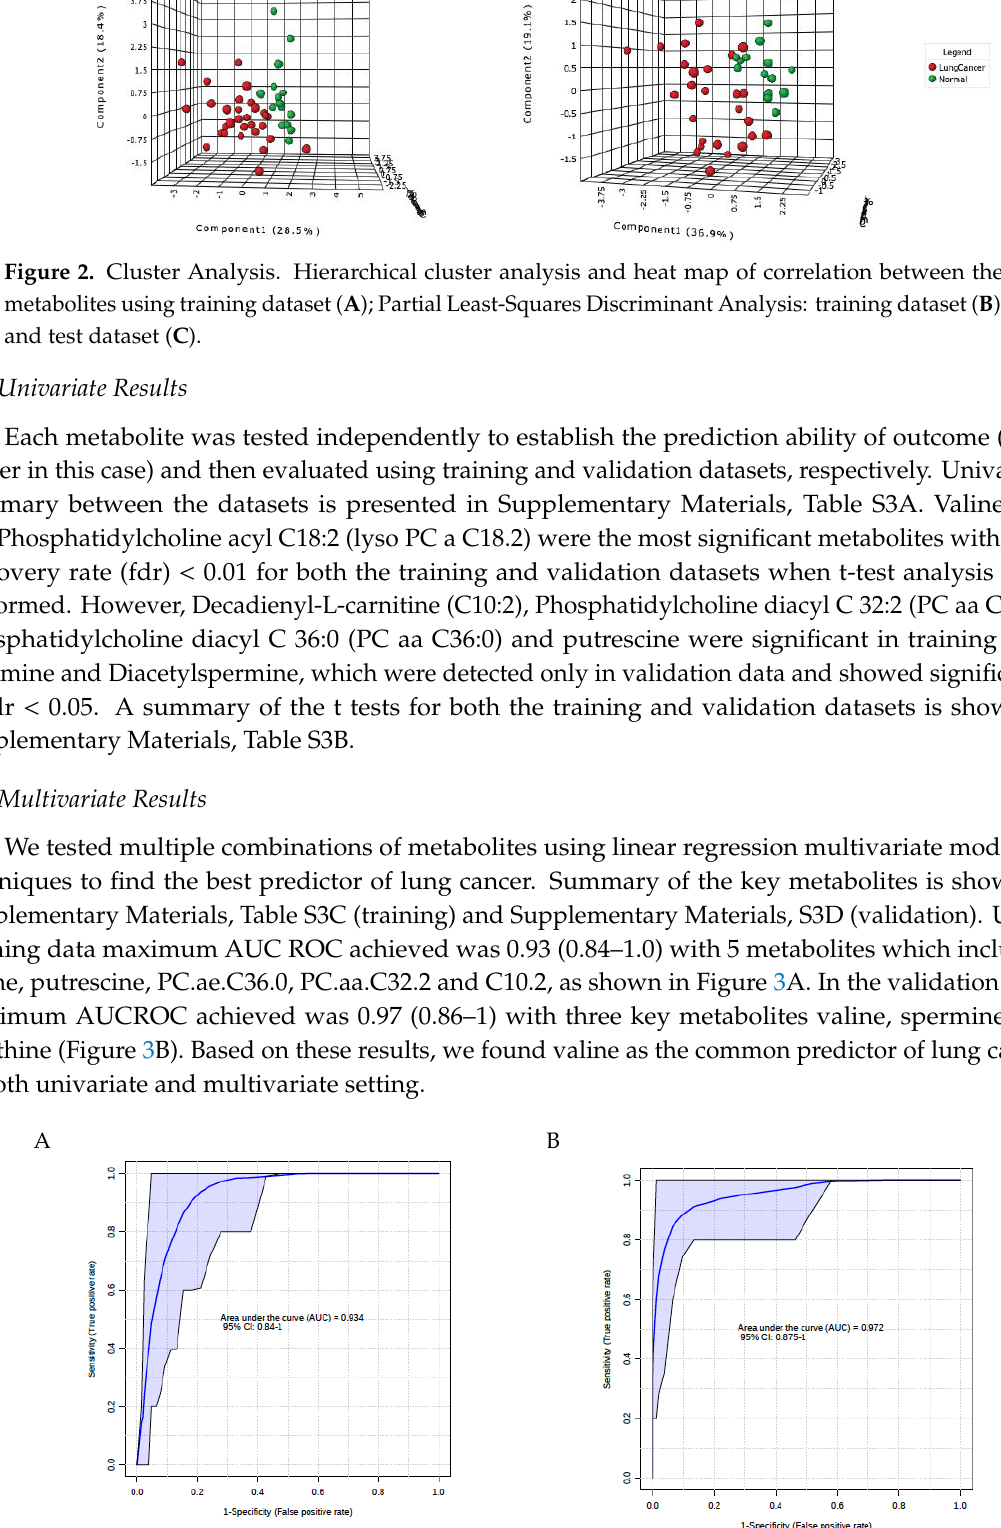
Figure 3. Linear regression multivariate modeling with multiple combinations of metabolites 5 metabolites included valine, putrescine, PC.ae.C36.0, PC.aa.C32.2 and C10.2 ( A ) and 3 key metabolites Valine, Spermine and Ornithine ( B